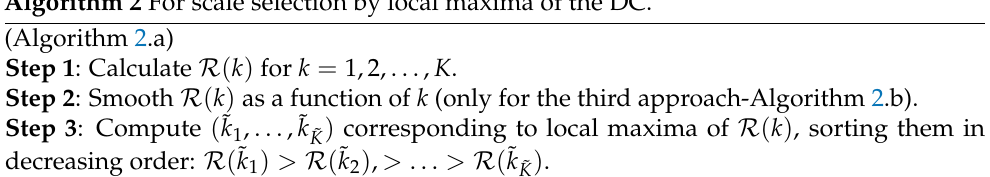
Algorithm 2 For scale selection by local maxima of the DC.